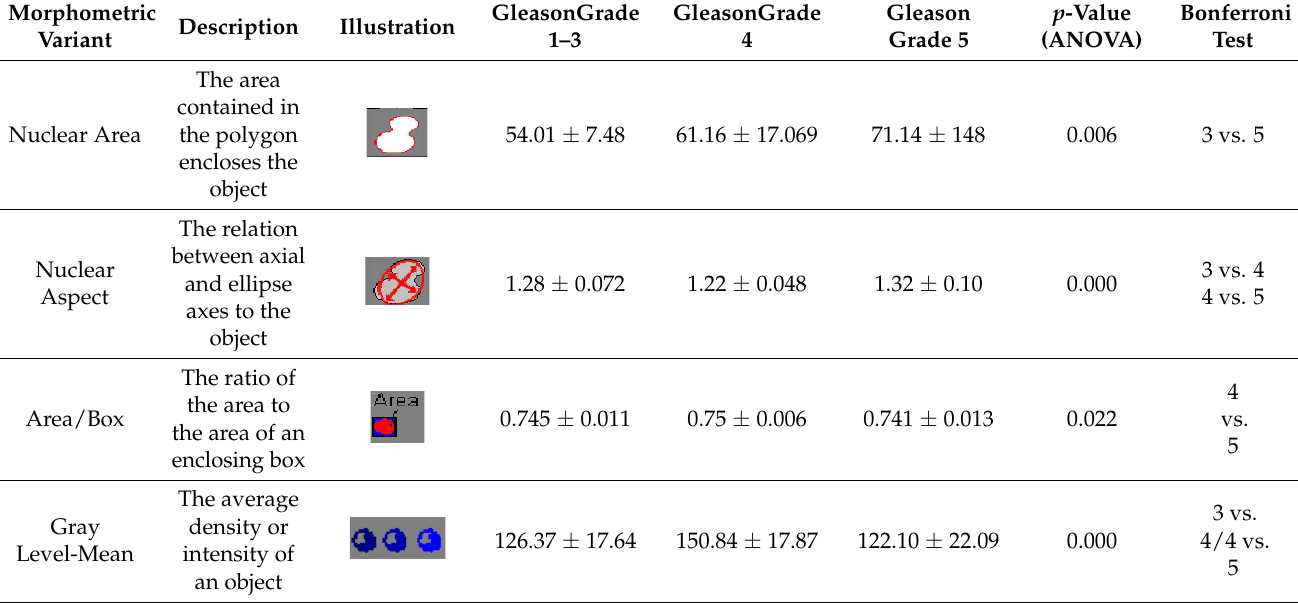
Table 1. Morphometric comparisons between the different levels of Gleason (univariate analysis).